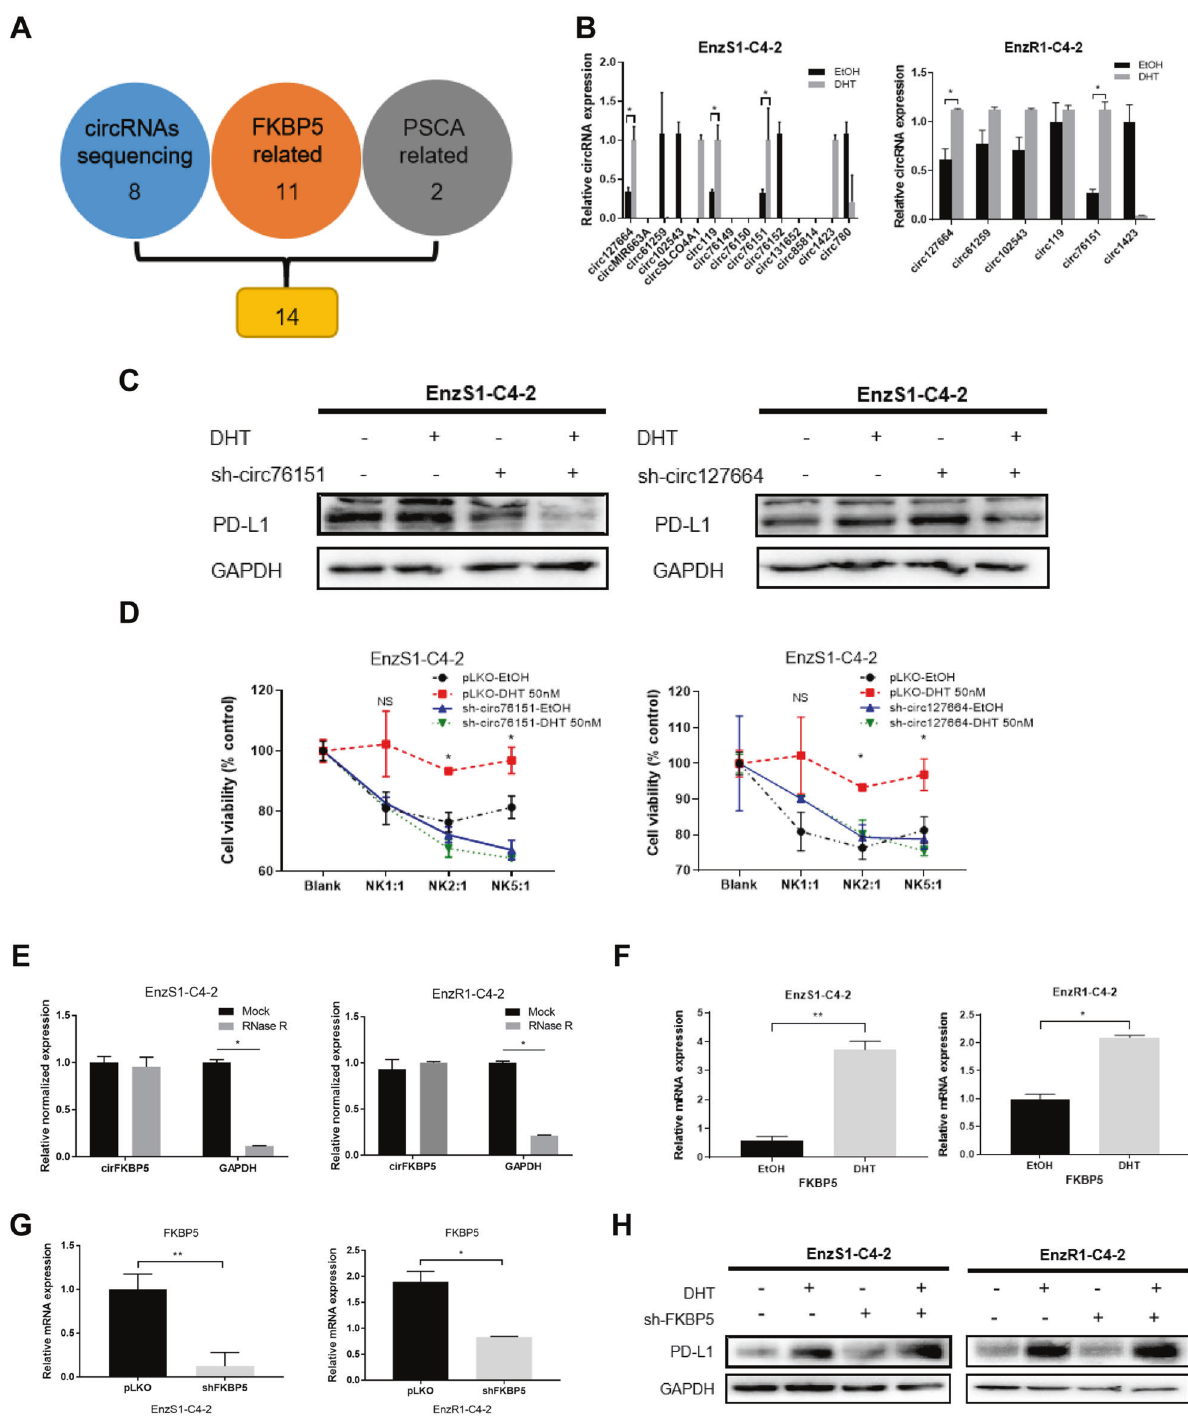
Fig. 4 A high dose DHT/AR can increase the PD-L1 expression via up-regulating the circFKBP5 expression. A Schematic diagram for prediction of 14 candidate circRNAs that were both related to AR target-genes (FKBP5 and PSCA) B qRT-PCR was performed to show quanti fi cation of 14 candidate circRNAs expression after 50 nM DHT treatment in EnzS1-C4-2 (left panel) and EnzR1-C4-2 (right panel) cells. C Western blot showed PD-L1 expression after sh-circ76151 (left panel), sh-circ127664 (right panel) in both cell lines and treated with 50 nM DHT or EtOH. D Before treating EnzS1-C4-2 cells with 50 nM DHT, circ76151 (left panel) and circ127664 (right panel) expressions were knocked down. After treatment, MTT assay was performed separately using NK92-MI cells to target EnzS1-C4-2 cells. E RNase R assay to determine the sensitivity of circFKBP5 by RNase R digestion in EnzS1-C4-2 (left panel) and EnzR1-C4-2 (right panel). F qRT-PCR was applied to test FKBP5 mRNA expression in EnzS1-C4-2 (left panel) and EnzR1-C4-2 (right panel) after 50 nM DHT treatment for 48 h. G qRT-PCR was performed to evaluate the ef fi cacy of knocking down FKBP5 (shFKBP5) in EnzS1-C4-2 (left panel) and EnzR1-C4-2 (right panel) with/without (w/wo) shFKBP5. H Western blot showed PD-L1 expression in both cell lines after sh-FKBP5 and treated with 50 nM DHT or EtOH. * p < 0.05 ** p < 0.01, NS = Not Signi fi cant.